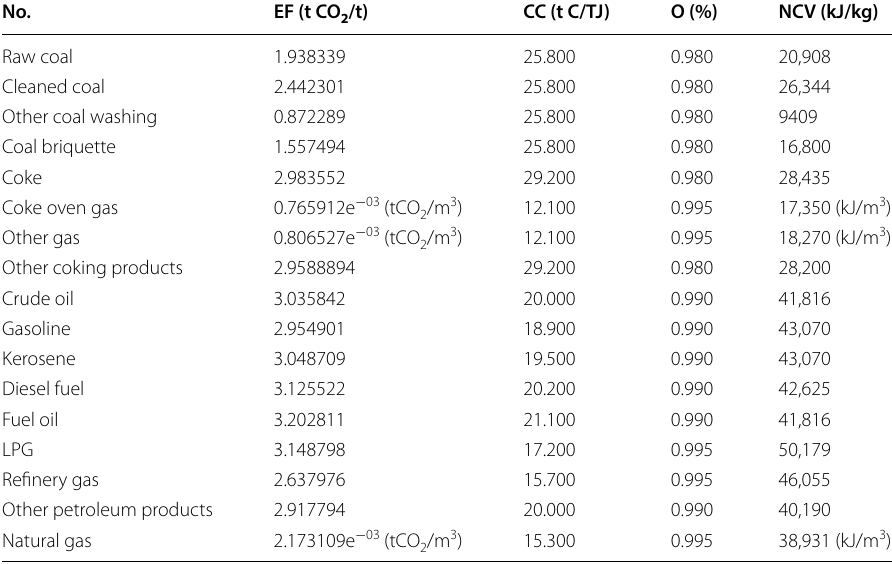
Table 1 The carbon emissions factor (EF) of different fuels